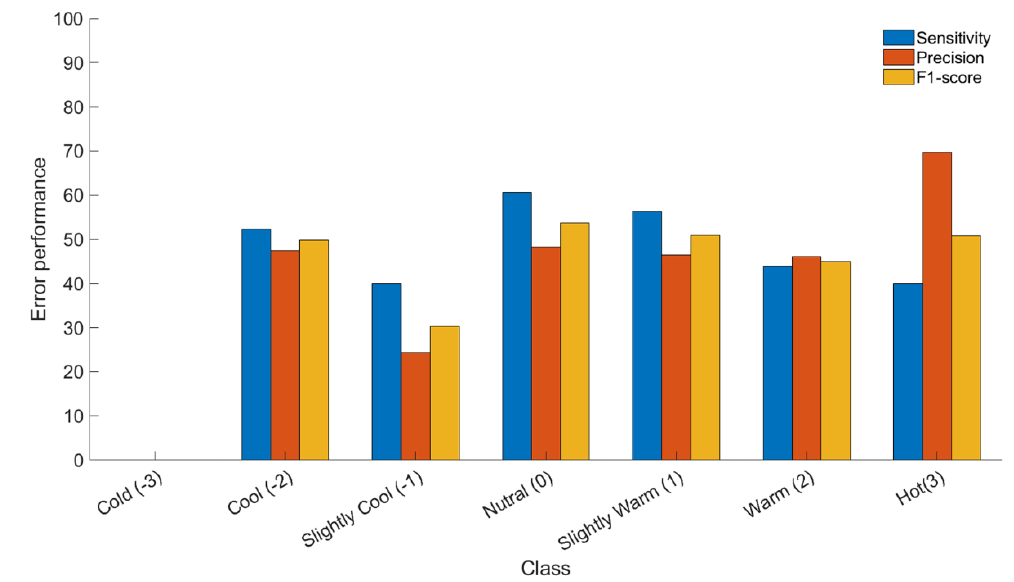
Figure 5. Error performance of the developed general classification model with 54 input features for 7-classes classification problem.